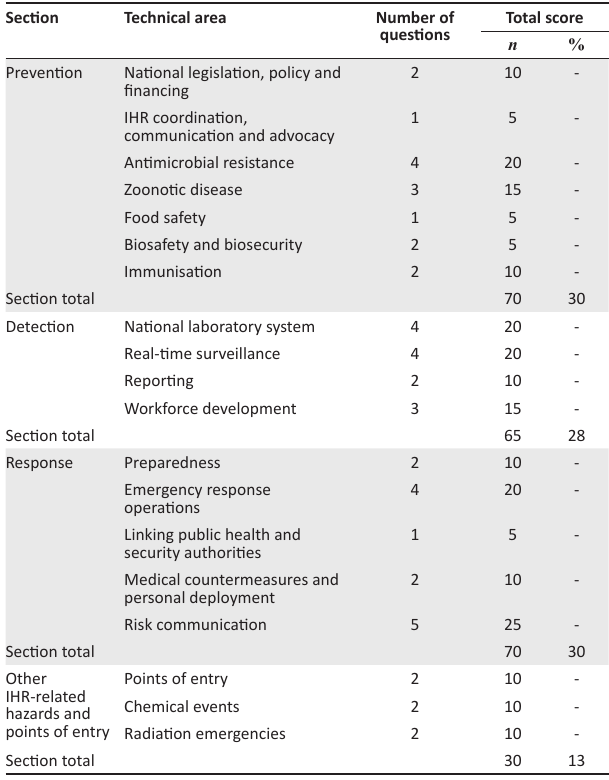
TABLE 1: Sections and technical areas of the WHO JEE